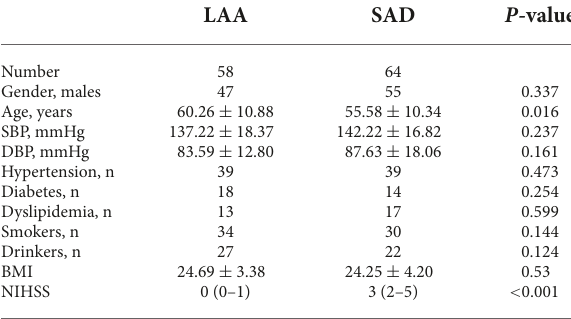
TABLE 1 Characteristics of LAA and SAD